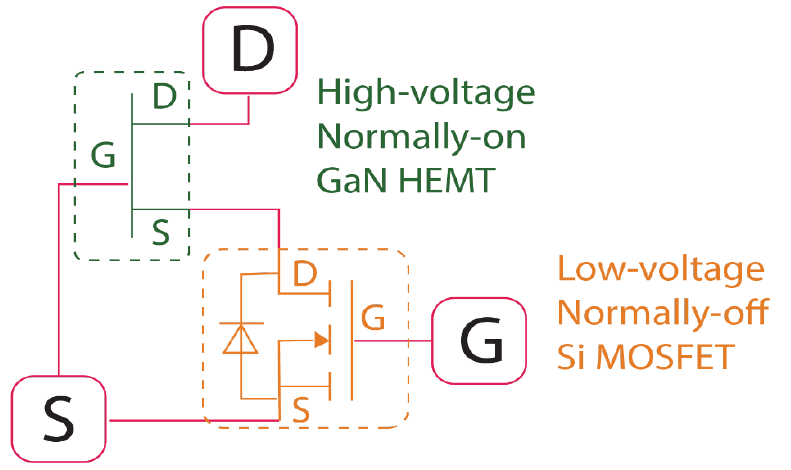
Figure 19. Normally-off HEMTs with cascode configuration